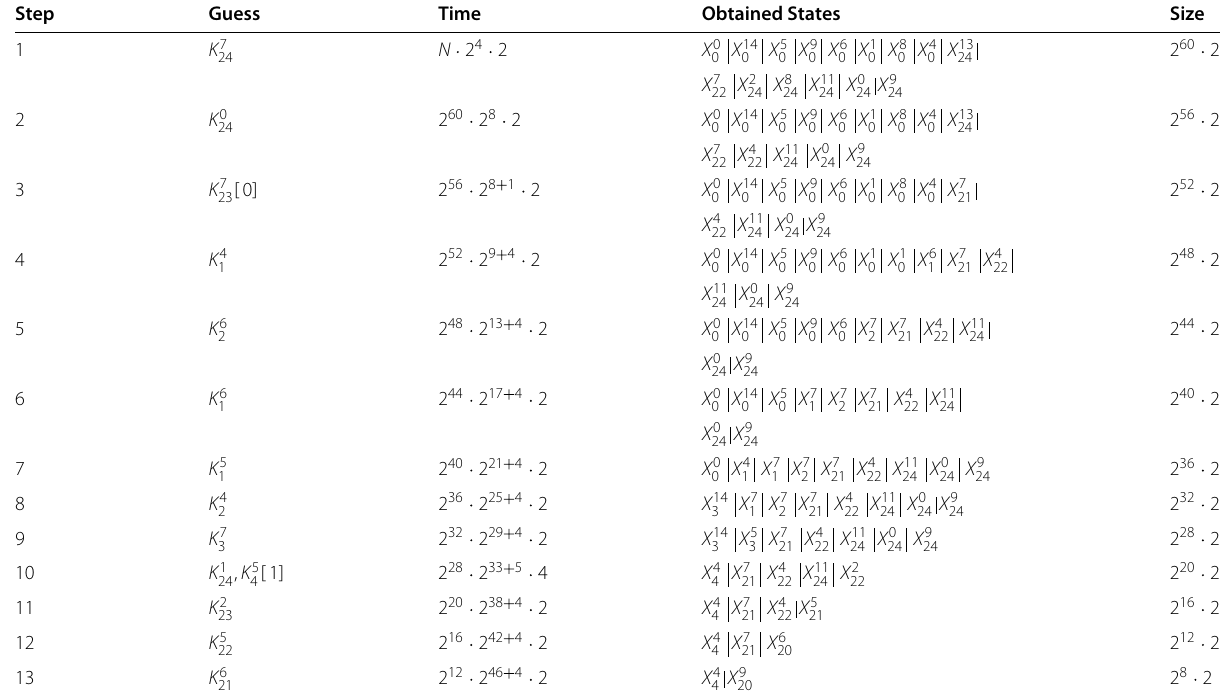
Table 5 Partial encryption and decryption on 24-round LBlock Step Guess Time Obtained States